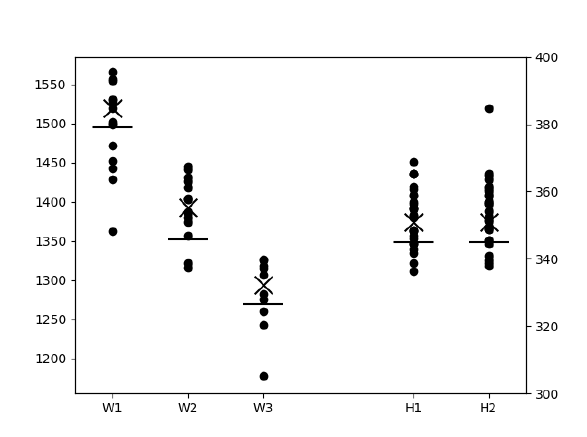
Figure 9. Monoscopic width (Z-axis) and height (Y-axis) estimates, in mm. Widths use the left axis, heights the right. Benchmark values are indicated with —, and triangulated multiscopic estimates with ×